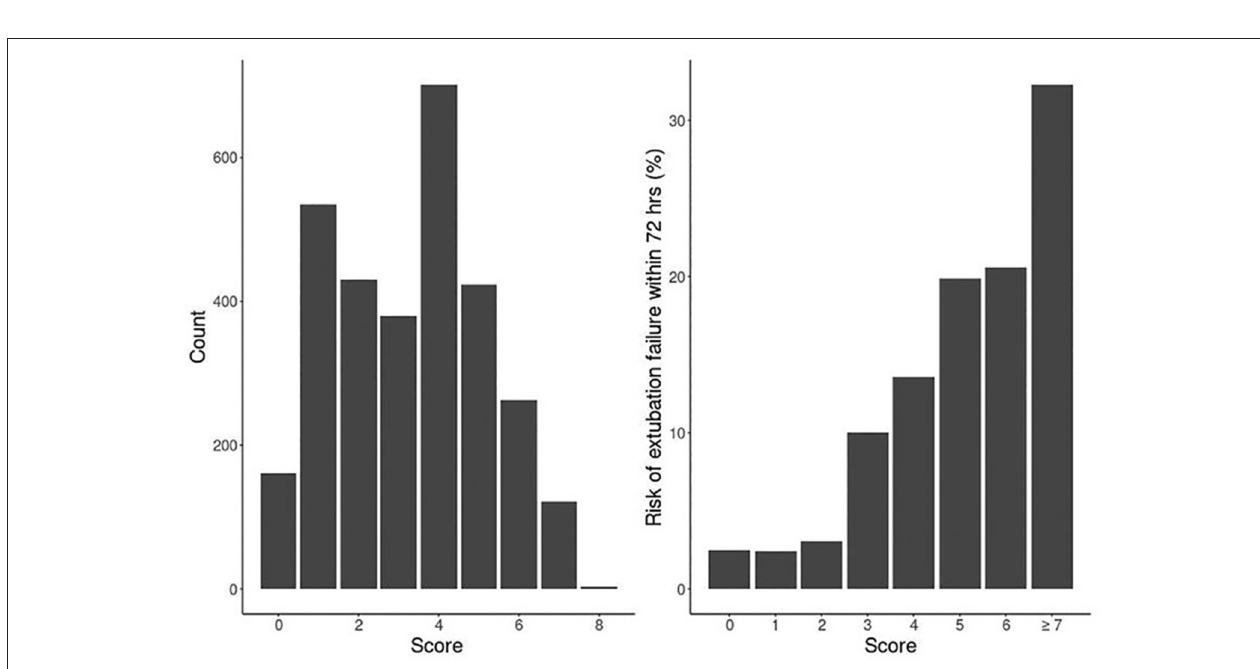
FIGURE 4 | Distribution of RISC score and the corresponding 72-h extubation failure rate (%).